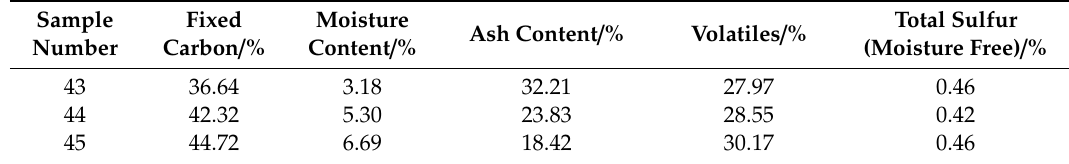
Table 1. Test results for the proximate and ultimate analysis of coal samples.